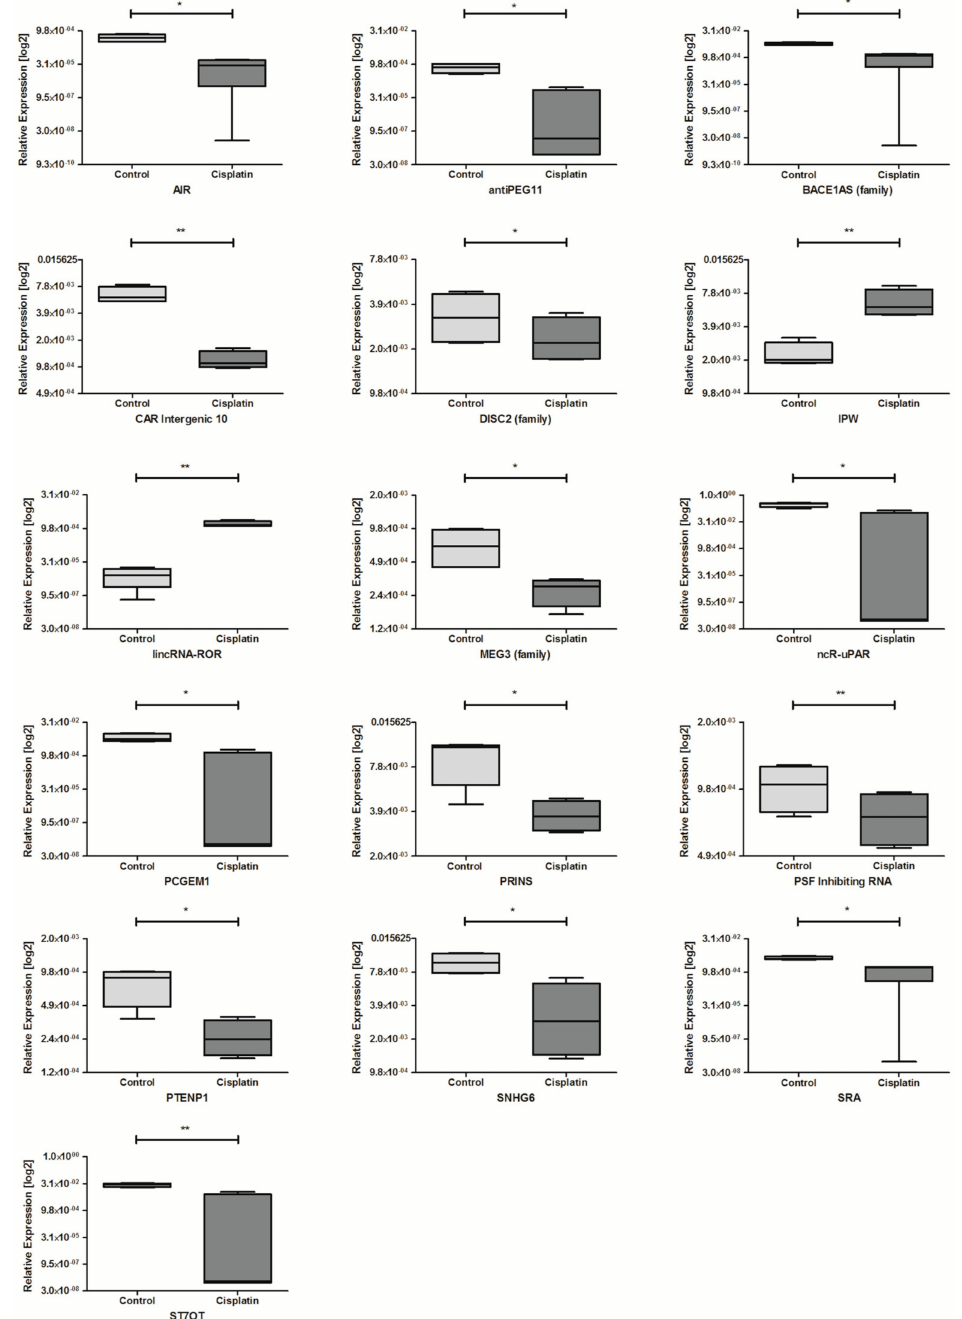
Figure 6. Differences in lncRNAs expression: AIR, antiPEG11, BACE1AS (family), CAR Intergenic 10, DISC2 (family), IPW, MEG3 (family), lincRNA-ROR, ncR-uPAR, PCGEM1, PRINS, PSF Inhibiting RNA, PTENP1, SNHG6, SRA, and ST7OT in HNSCC cell lines after exposure to cisplatin. Paired t -test; the graphs show relative expression, mean value with SEM; * p < 0.05, ** p <